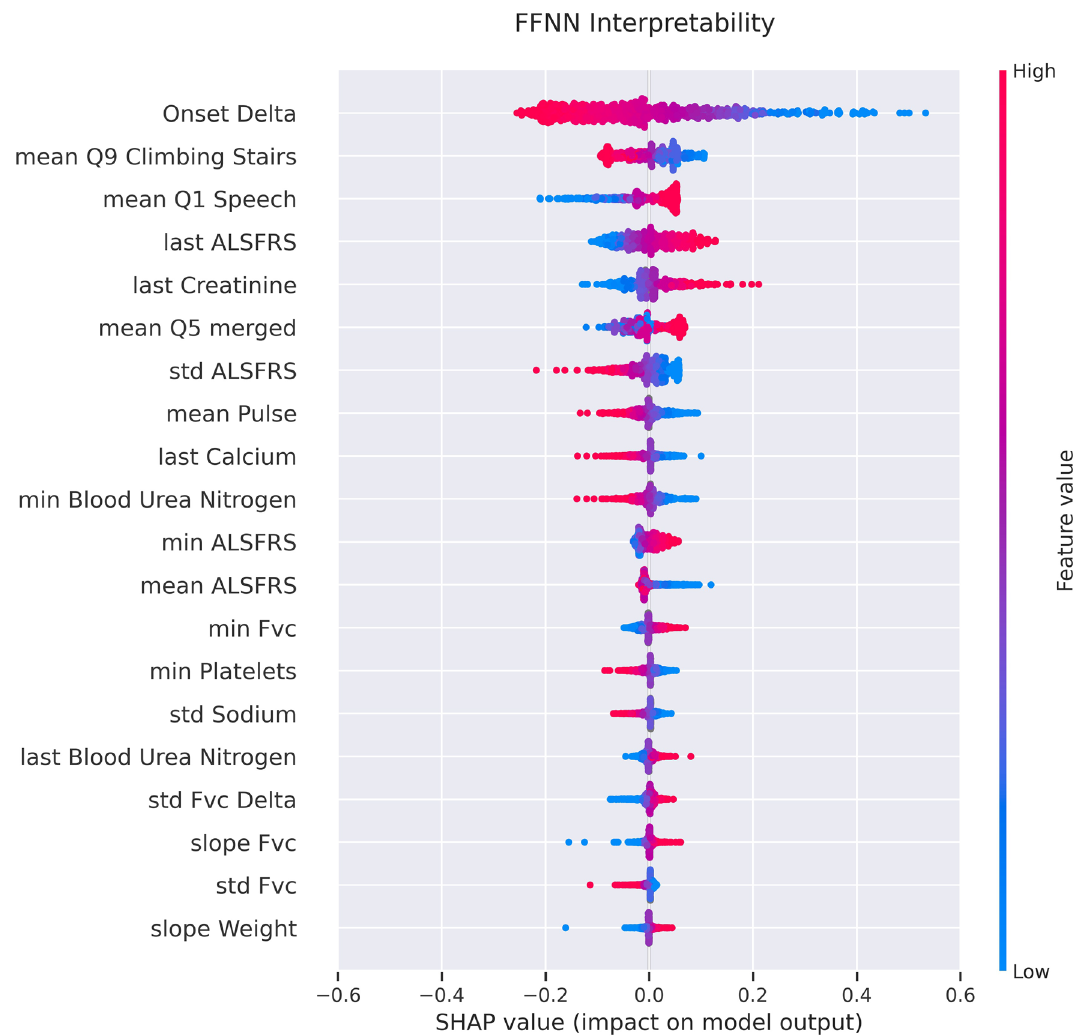
Figure 4. Shapley values for the FFNN architecture; x-axis: the impact on the model output, y-axis: the top 20 most predictive features. The colormap represents the feature values.